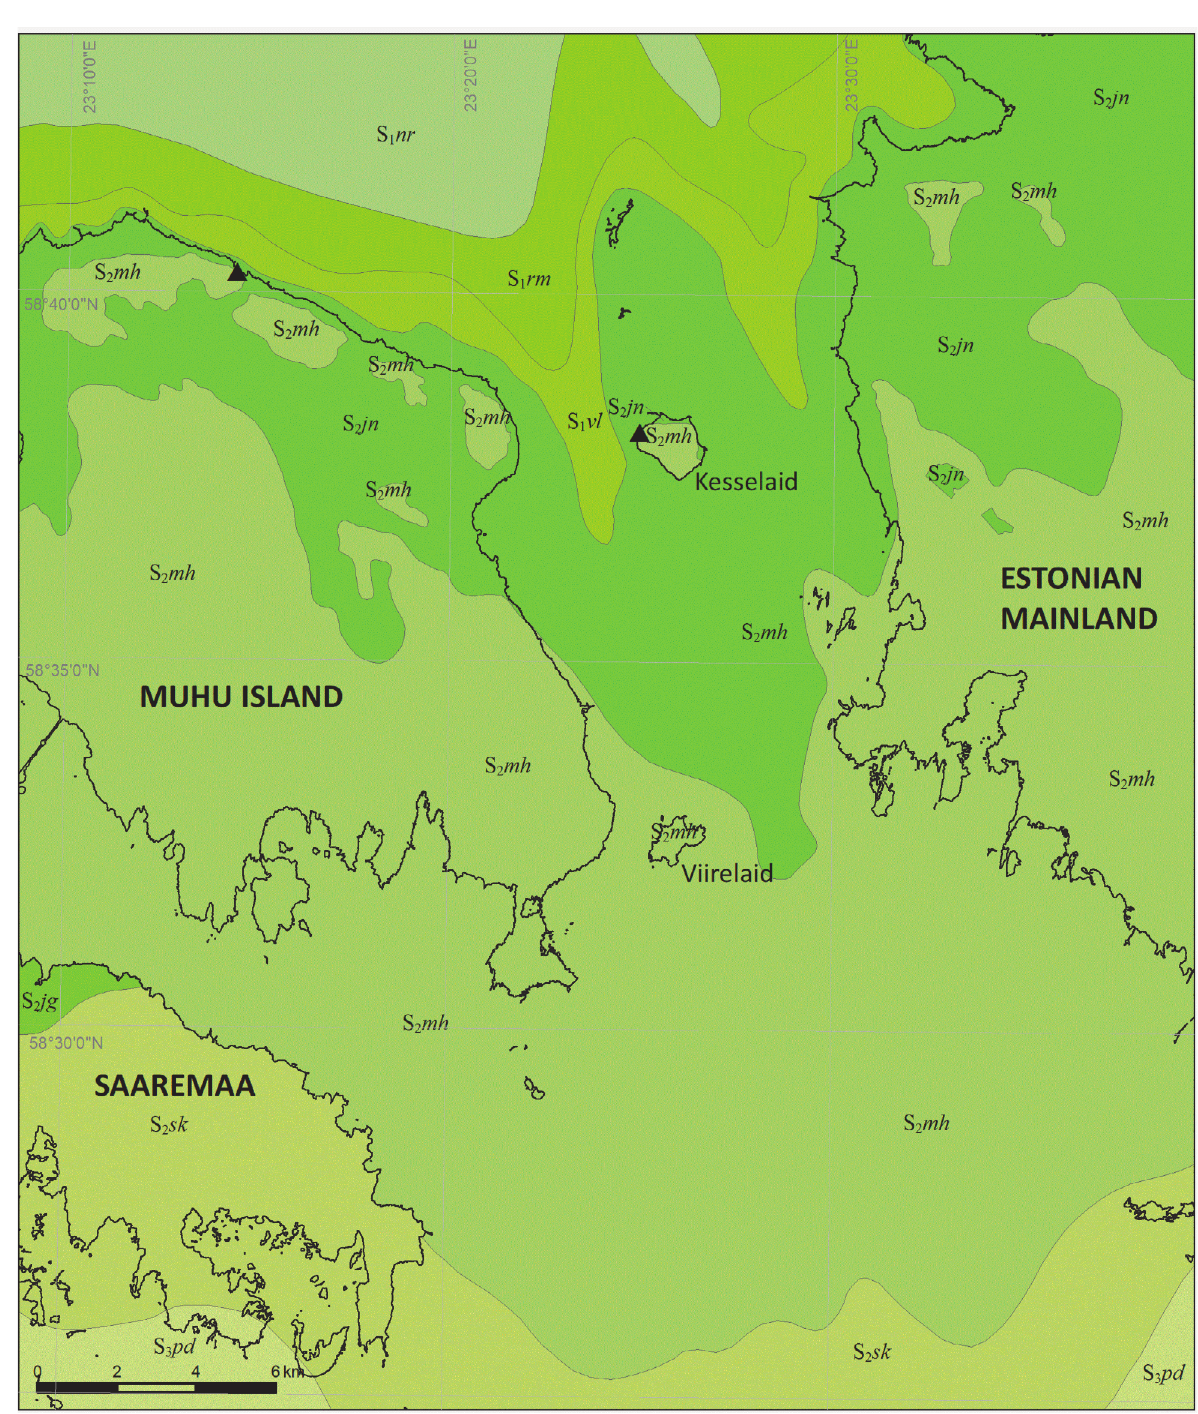
Fig. 3. Geological map of the Suur Strait with adjacent onshore areas. Indexes mark the following Silurian formations: S 1 nr – Nurmekund Formation, S 1 rm – Rumba Formation, S 1 vl – Velise Formation, S 2 jn – Jaani Formation, S 2 mh – Muhu Formation, S 2 jg – Jaagarahu Formation, S 2 sk – Sakla Formation, S 3 pd – Paadla